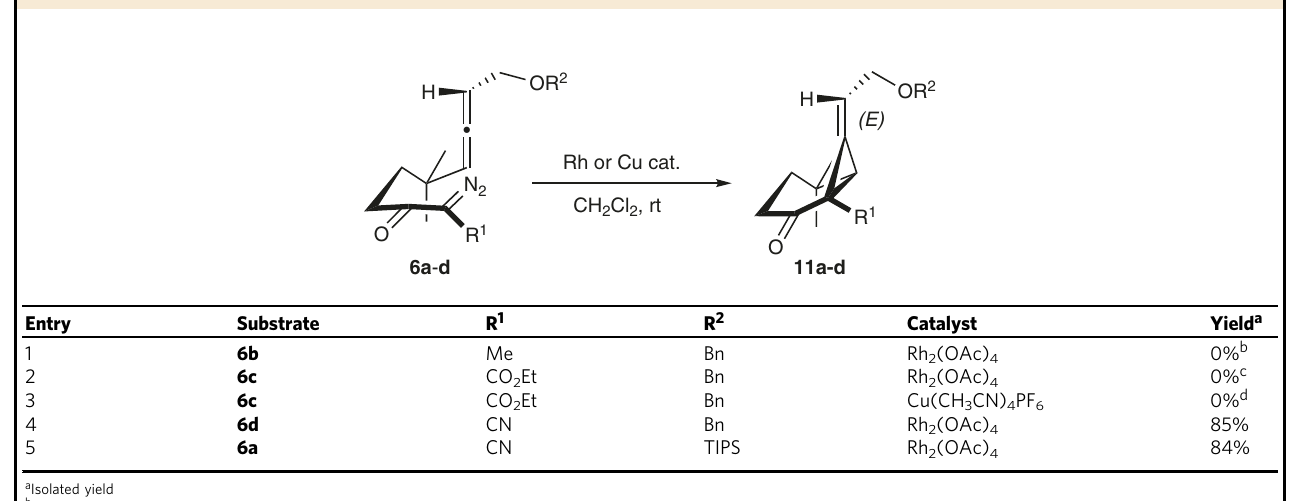
Table 1 Formation of alkylidenecyclopropane by allene cyclopropanation